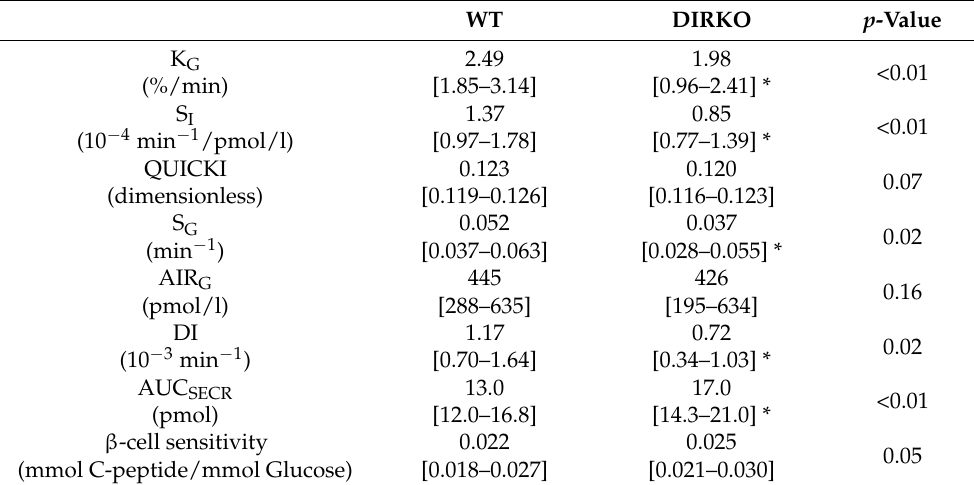
Table 2. Metabolic assessment for DIRKO and WT